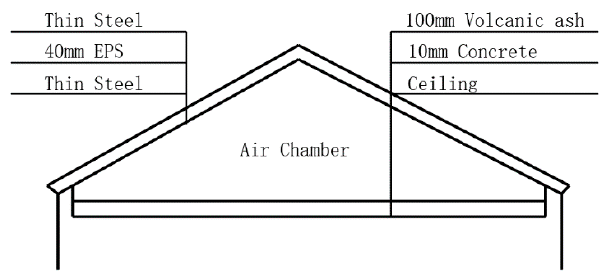
Figure 10. Details of the enclosed roof.